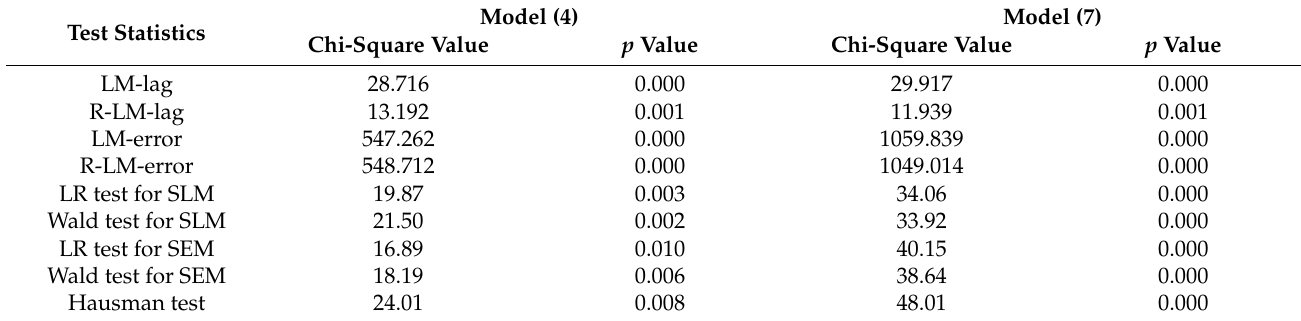
Table 2. Results of the applicability test of the spatial panel model.